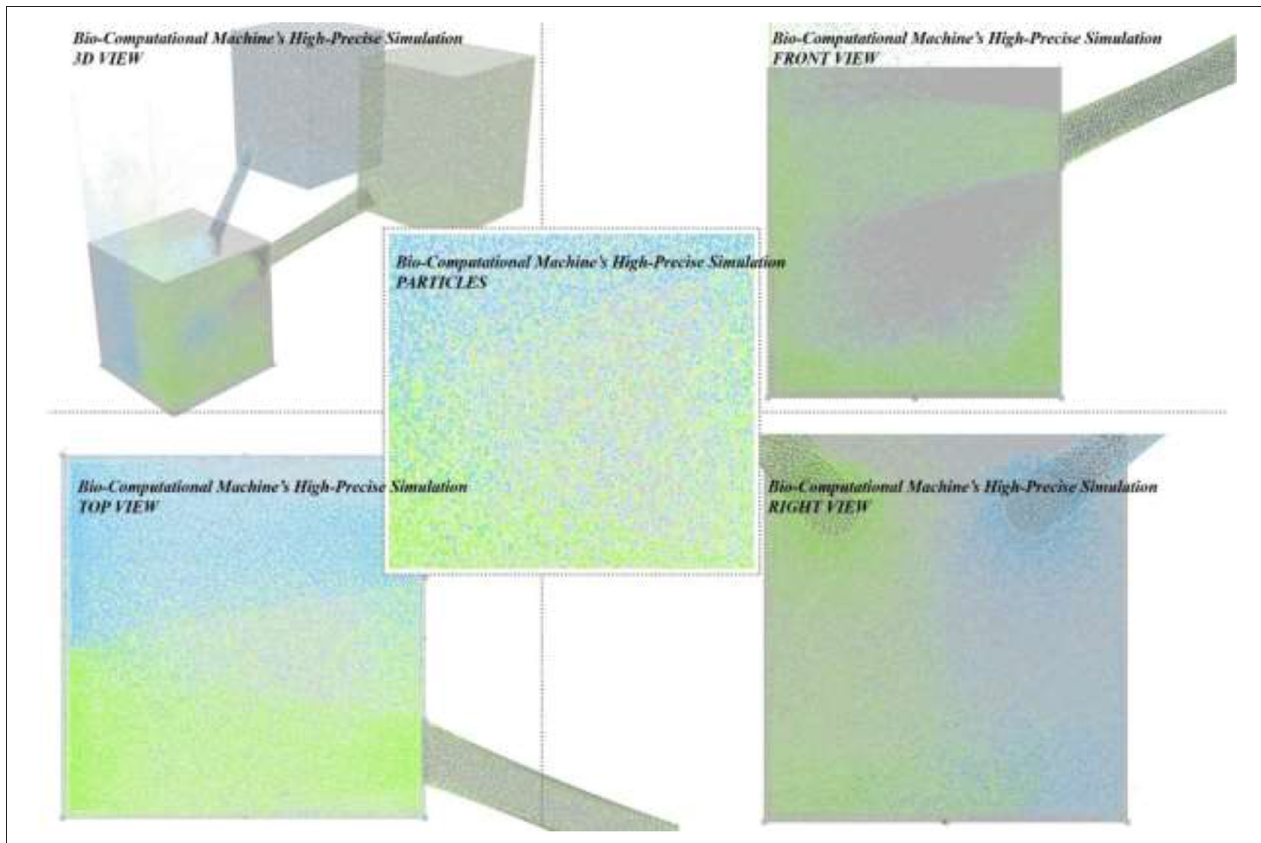
FIGURE 7 | Bio-computational machine’s high-precise simulation by position-based dynamics engine and particle